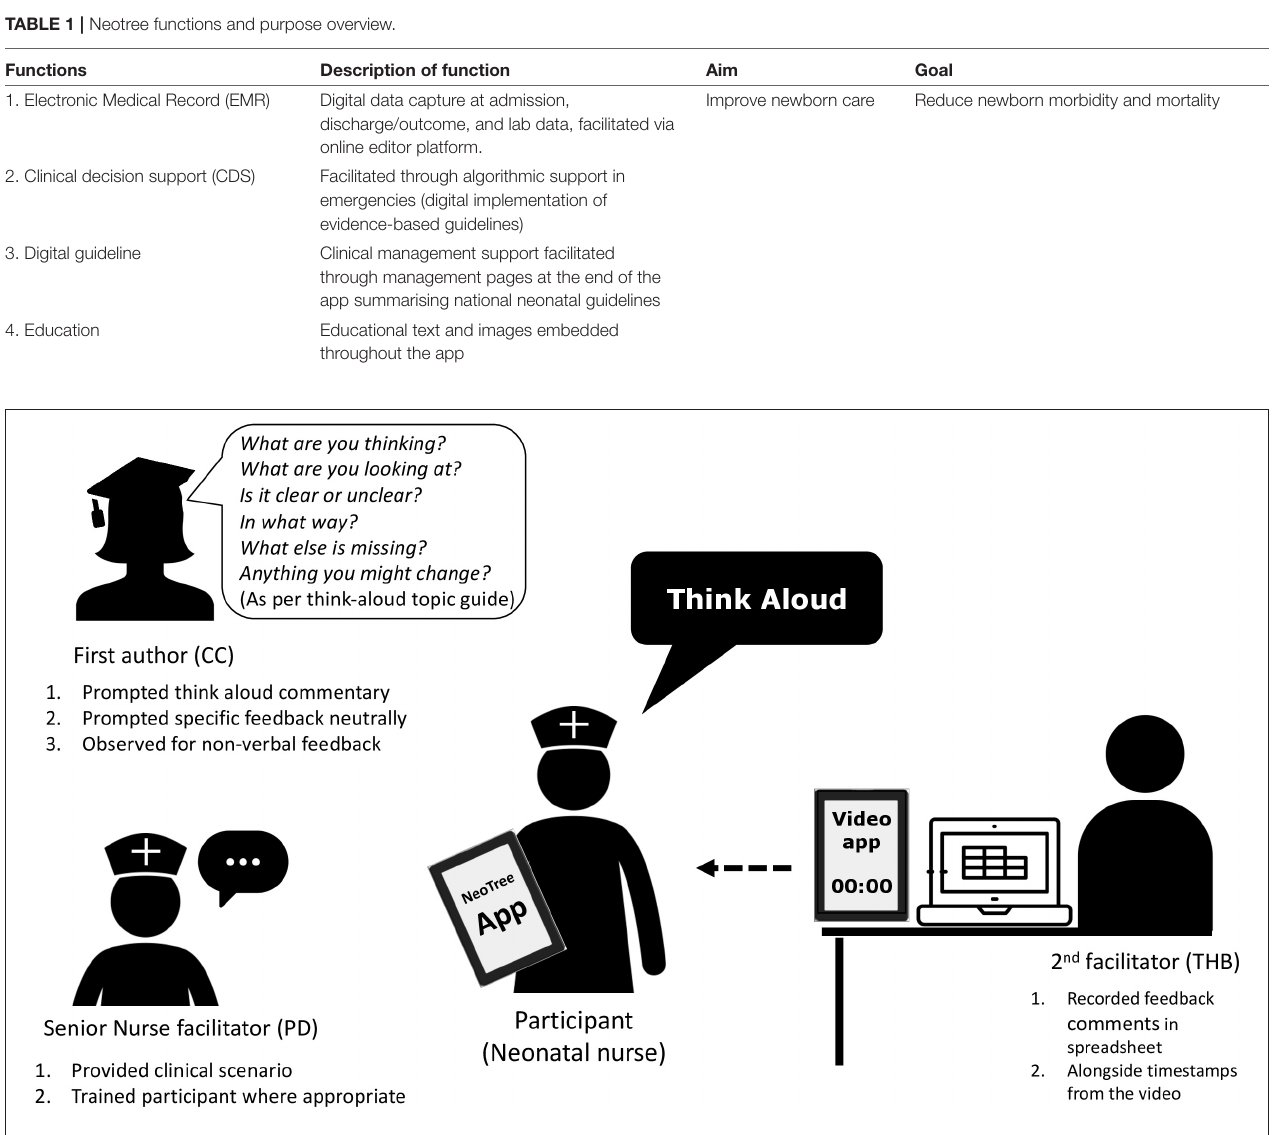
FIGURE 5 | App usability